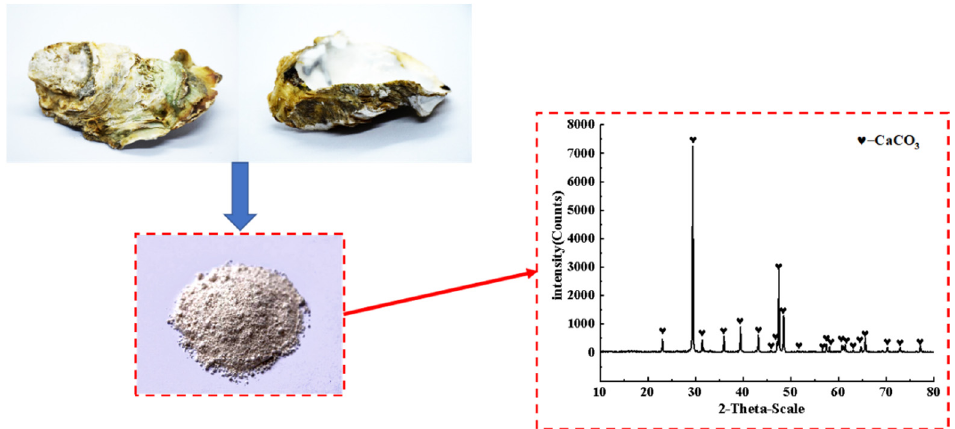
Figure 3. Discarded oyster shells and X-ray diffraction (XRD) analysis. Table 4. Chemical components of oyster shell powder (OSP).